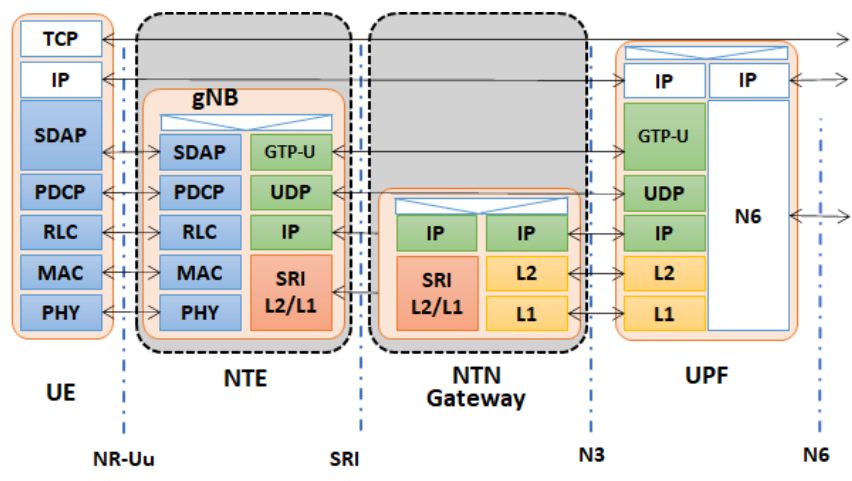
Figure 6. Protocol stack of the user plane in the regenerative NTN architecture